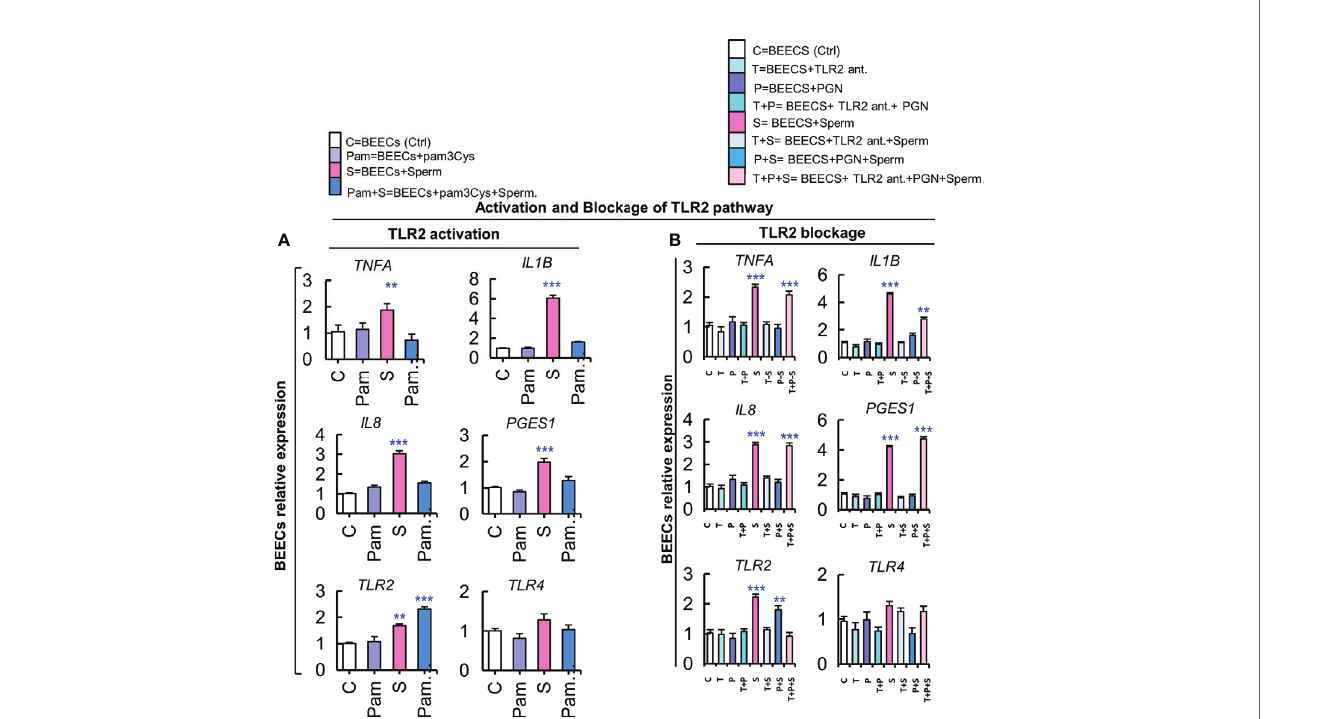
FIGURE 5 | Activation of the TLR2 pathway suppresses the stimulatory effect of sperm on transcription of in fl ammatory cytokines, while a TLR2 blockade removed the PGN suppressive effect on sperm-induced in fl ammation in BEECs. (A) BEECs activation with pam3Cys (synthetic TLR2 agonist). Subcon fl uent BEEC monolayers were exposed to pam3Cys (10 pg ml − 1 ) for 24 h followed by co-culturing with sperm for 6 h. (B) Blockage of TLR2 with synthetic TLR2 antagonist. BEECs were pre-exposed to CU-CPT22 (0.1 m M = 36.24 ng ml − 1 ) for 3 h followed by exposure to PGN (10 pg ml − 1 ) for 24 h before co-culturing with sperm for 6 h. The mRNA expression of major in fl ammatory genes was assessed using RT-PCR assay. Data are presented as mean ± SEM of 3 independent experiments using epithelial cells from 3 different uteri (3 wells/treatment/experiment). Asterisks denote a signi fi cant variance (*P<0.05 **P<0.01 , or ***P<0.001) between the different groups when compared to the control